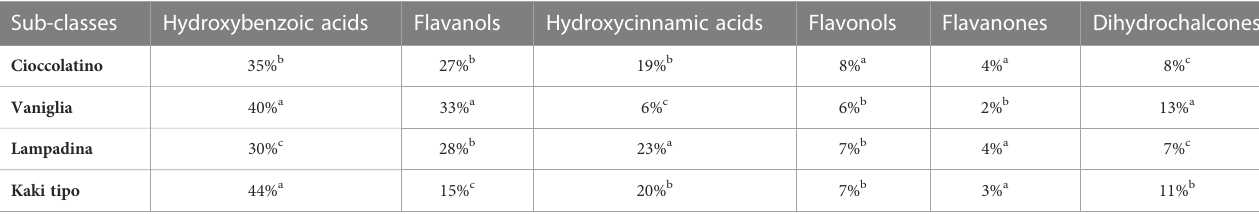
TABLE 3 Percentage contribution of each compound sub-class to whole polyphenolics present in the fruit of Kaki tipo, Cioccolatino, Vaniglia and Lampadina cultivars. Sub-classes